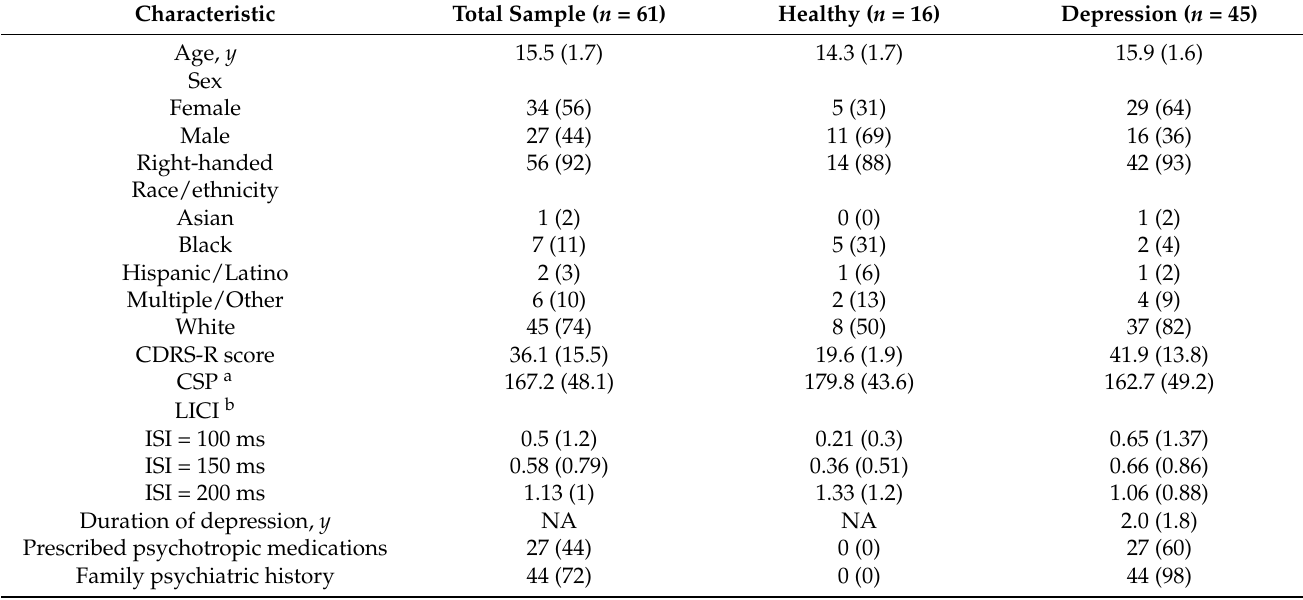
Table 1. Demographic and clinical characteristics.